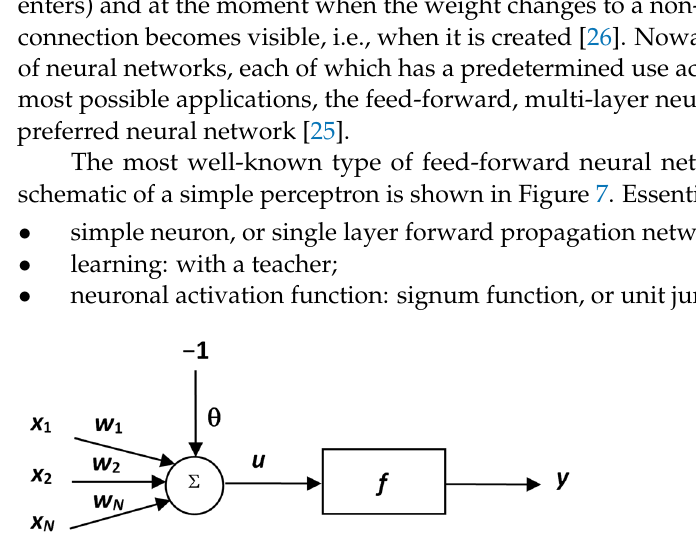
Figure 7. Simple Figure 7. Simple perceptron.